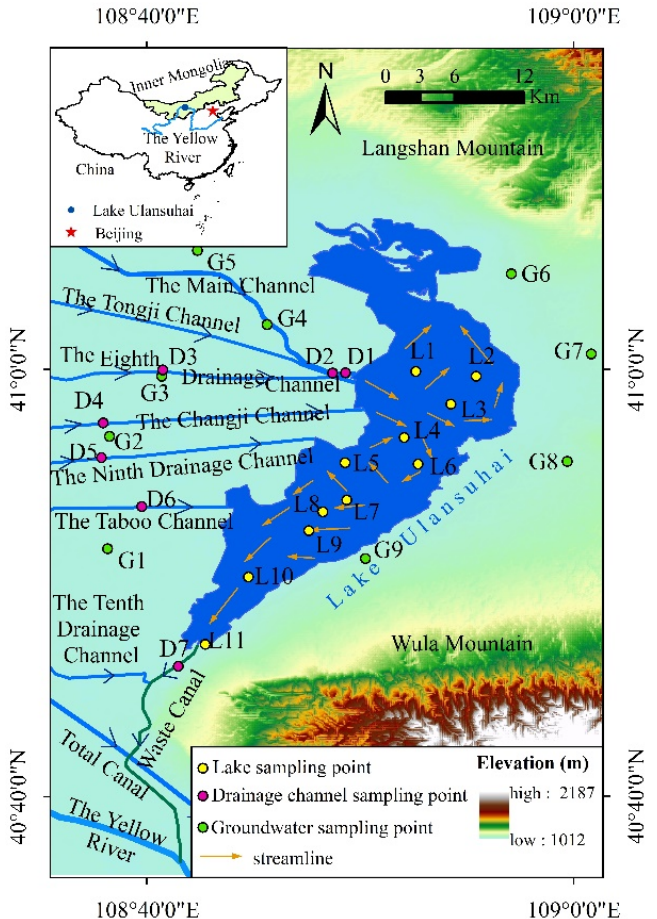
Figure 1. Location of the study area and the sampling sites.